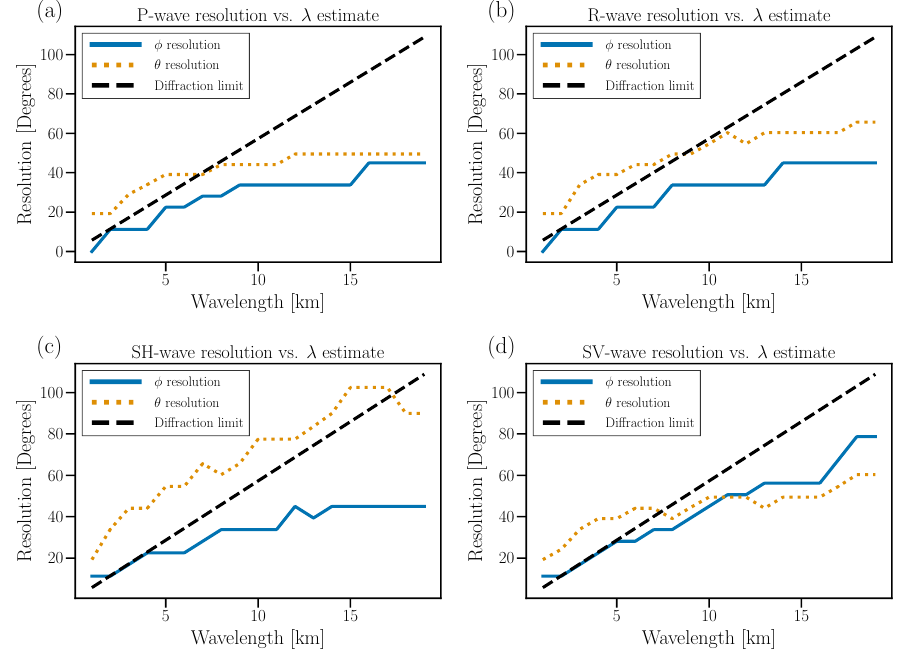
Figure 3. An estimate of the angular resolution for the different components of the seismic field M true (see text) for P, R S h , and S v waves ( a – d ). The resolution is estimated by drawing based on M a contour around the region containing 95% of the total map power and finding the extent in the azimuth ( φ ) and polar ( θ ) angle that this contour encompasses. We also show the diffraction limit estimate on each plot.